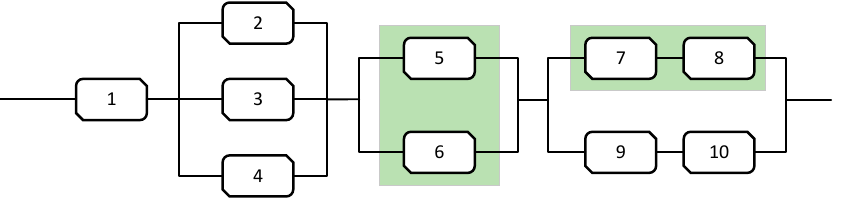
Figure 5. Diagram of a typical series–parallel manufacturing system.